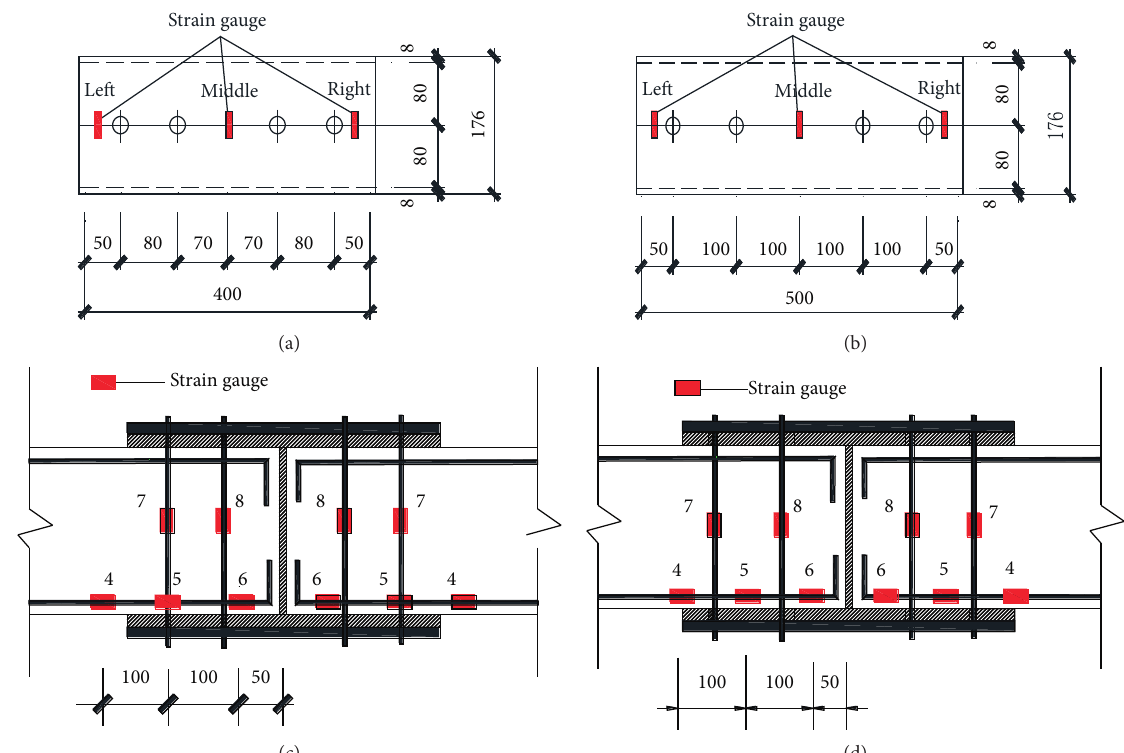
Figure 6: Strain gauge layout. (a) The position of bolts and gage in PRCB-01, (b) the position of bolts and gage in PRCB-02, (c) the position of bars gage in PRCB-01, and (d) the position of bars gage in